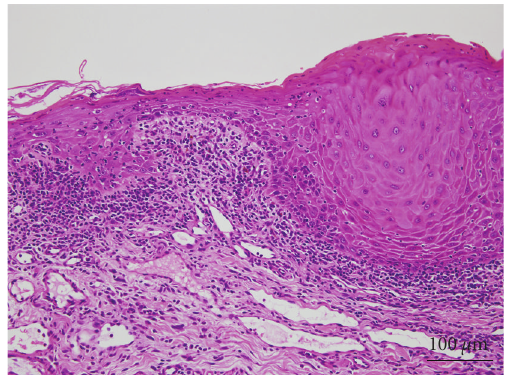
Figure 2: Scattered crusted and erosive lesions with flaccid bullae on the chest.